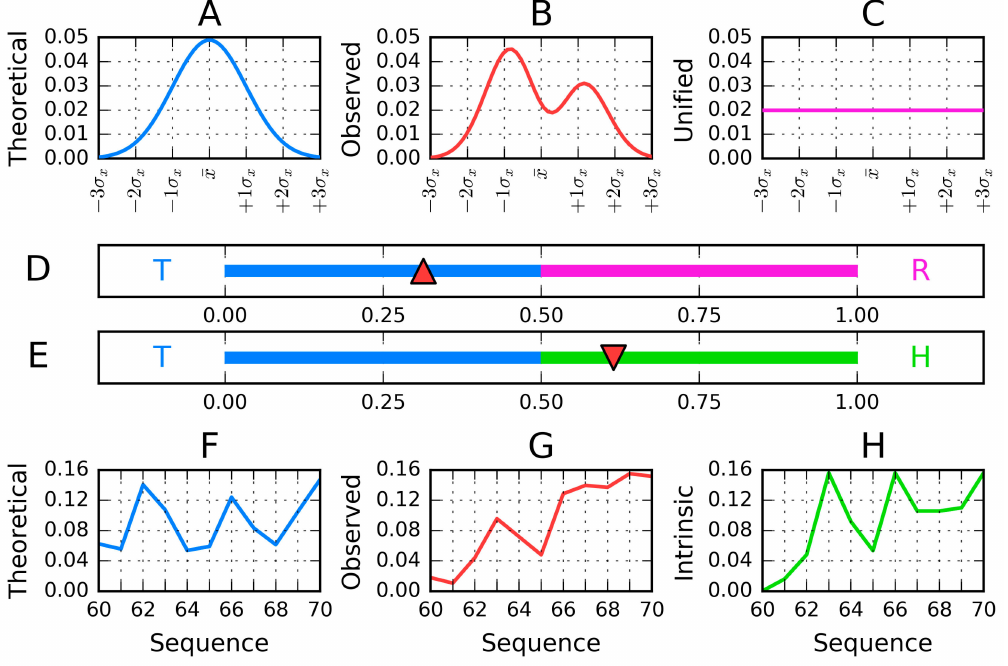
Figure 10. Visualization of the presented model, reduced to a single dimension for the sake of clarity: ( A )—Gaussian distribution superimposed onto the protein molecule (T); ( B )—Observed distribution in the molecule under consideration (O) ( C )—Uniform distribution (R) ( D )—Part of the Gaussian distribution plotted for the selected fragment (T i–f ) ( E )—Observed distribution plotted for the selected fragment (O i–f ) ( F )—Intrinsic distribution plotted for the selected fragment (H i–f ) ( G )— RD scale